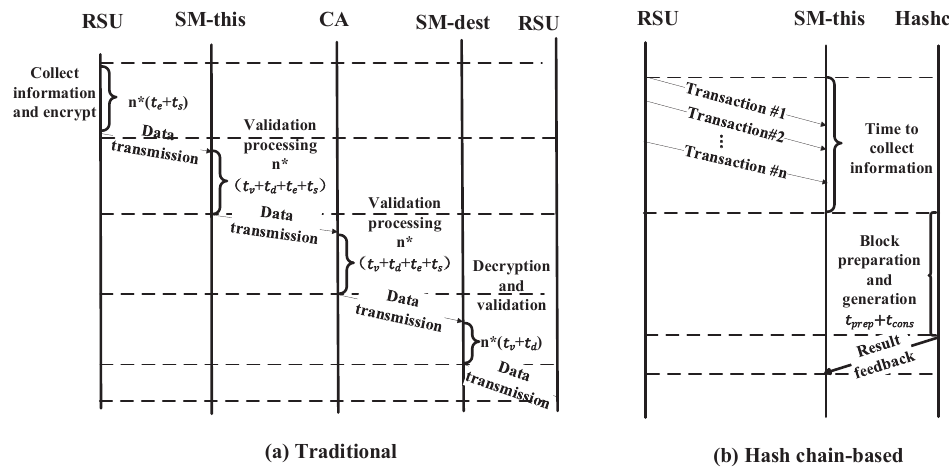
Figure 4. Cross-regional authentication process under different network